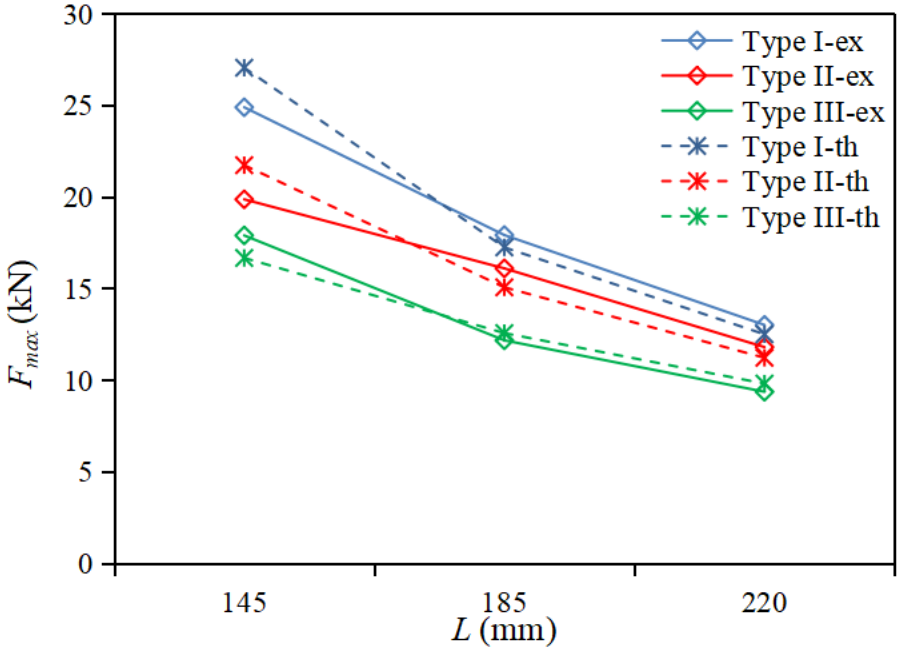
Figure 5. Comparison of theoretical and experimental (average) F max for the specimens with different designs under compression (the abbreviations ‘ex’ and ‘th’ represent the experimental and theoret- ical data, respectively; the lines in blue, red and green represent to cross-section of Type I, Type II and Type III).